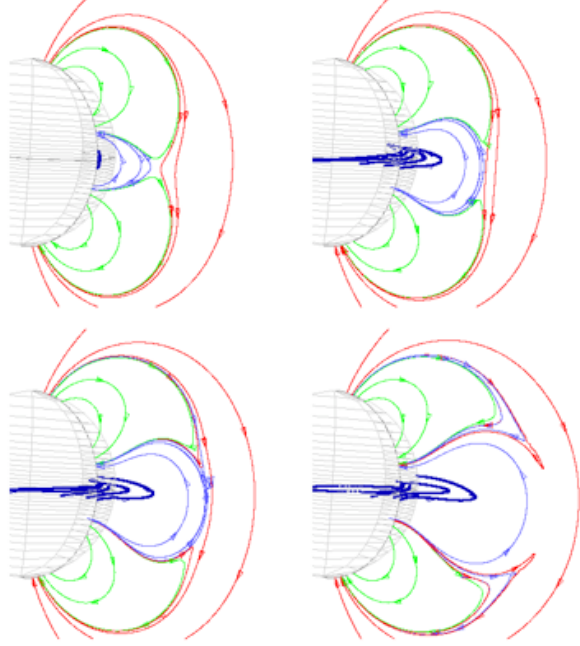
Fig. 5. The breakout model involves the large-scale magnetic envi- ronment in CME initiation, but neither the CME width is defined by the large-scale field nor it leads to wide-spread dimming (Antiochos et al.,